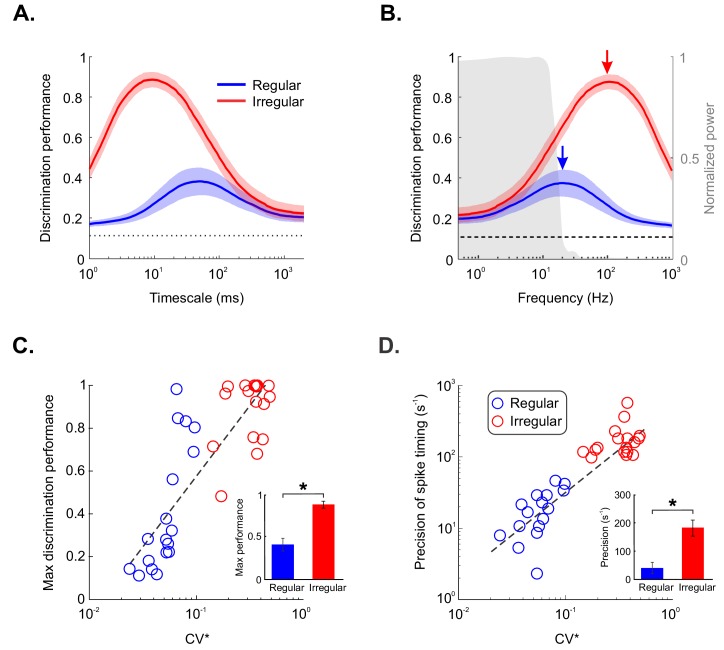
Using a different spike train metric (in this case, Van Rossum) does not affect the nature of our results.(A) Population-averaged discrimination performance for irregular (red) and regular (blue) afferents as a function of timescale. Chance performance is also shown (dashed line). The shaded color bands around the curves show one SEM. (B) Population-averaged discrimination performance for irregular (red) and regular (blue) afferents as a function of frequency (i.e., inverse of timescale). Chance performance (dashed line) and the stimulus power spectrum (shaded great) are also shown. The shaded color bands around the curves show one SEM. (C,D) Discrimination performance (C) and precision of spike timing (D) as a function of baseline variability, as quantified by CV* for regular (blue) and irregular (red) afferents. Afferents with higher CV* tended to display greater discrimination performance (R = 0.83, p=6.27E-10) as well as higher spike-timing precision (R = 0.77, p=3.35E–8). Insets: population-averaged discrimination performance (C) and spike-timing precision (D) for regular (blue) and irregular (red) afferents were significantly different from one another (performance, p=3.95E–05; precision, p=6.49E–06). '*' indicates statistical significance at the p=0.05 level using a Wilcoxon ranksum test.